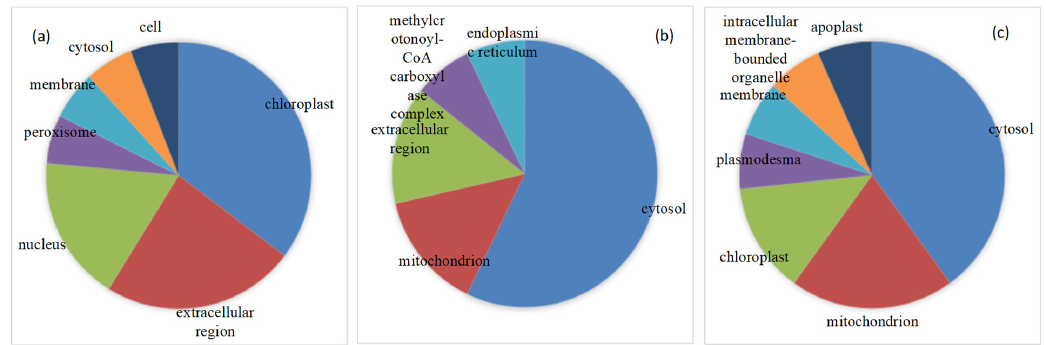
Figure 6. Subcellular location of up-regulated proteins involved in stress and redox regulation ( a ), amino acid metabolism ( b ) as well as carbohydrate and energy metabolism ( c ).